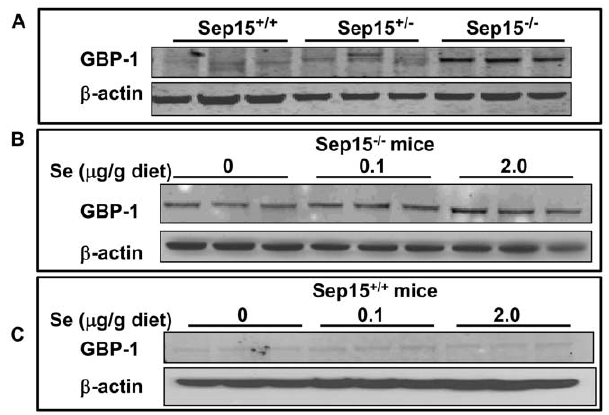
Figure 5. GBP-1 expression in mouse colonic epithelia. GBP-1 expression was examined by Western blots in colonic epithelia of (A) Sep15 knockout (Sep15 2 / 2 ), heterozygous (Sep15 + / 2 ) and wild type allelic (Sep15 + / + ) littermate control mice on 0.1 m g selenium/g diet, (B) Sep15 2 / 2 mice on 0, 0.1 or 2.0 m g selenium/g diet, and (C) Sep15 + / + litter mate controls on 0, 0.1 or 2.0 m g selenium/g diet. Protein extracts were loaded at 40 (A, B) or 60 m g (C) per lane. b -actin was used as the loading control. All experiments were carried out in triplicate.